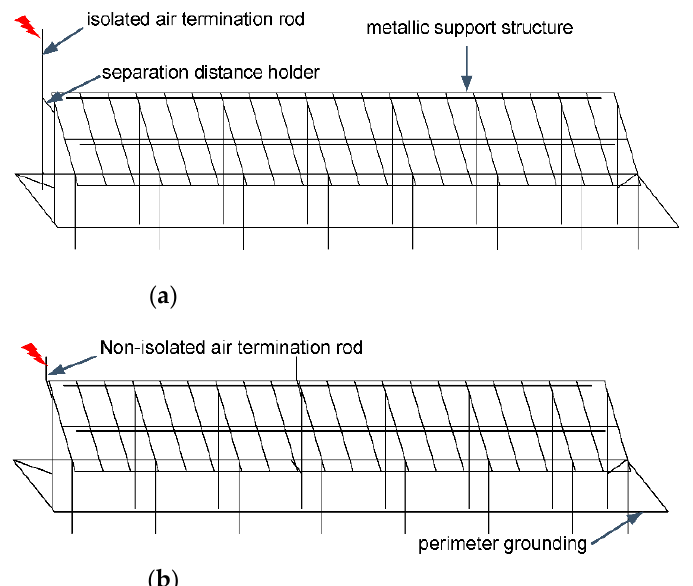
Figure 2. Basic 3D simulation model with ( a ) isolated LPS and ( b ) non-isolated LPS.